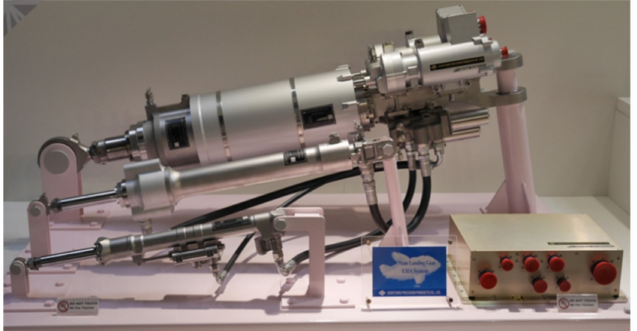
Figure 20. Mutualization of electrically supplied hydraulic generation for landing gears, Thermae II